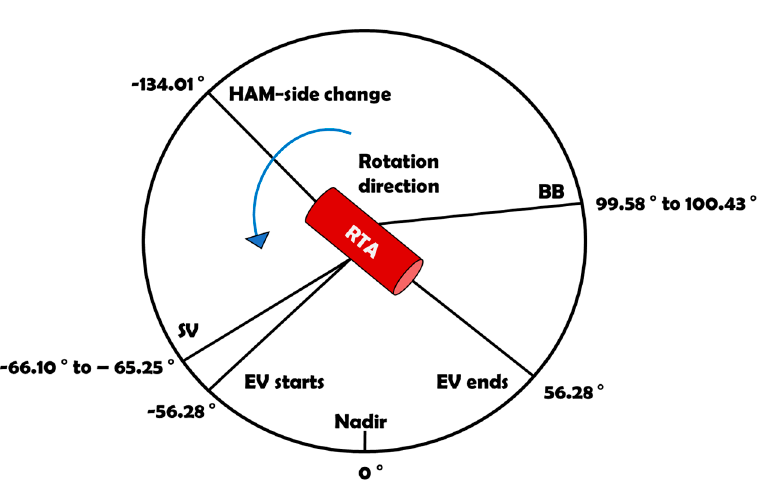
Figure 5. Schematic simplification of the RTA as it rotates and views the sectors (with their respective scan angles) used for the VIIRS TEB calibration. Not to scale. Table 3. VIIRS TEB calibration algorithm acronyms and definitions. Listed in order of appearance.